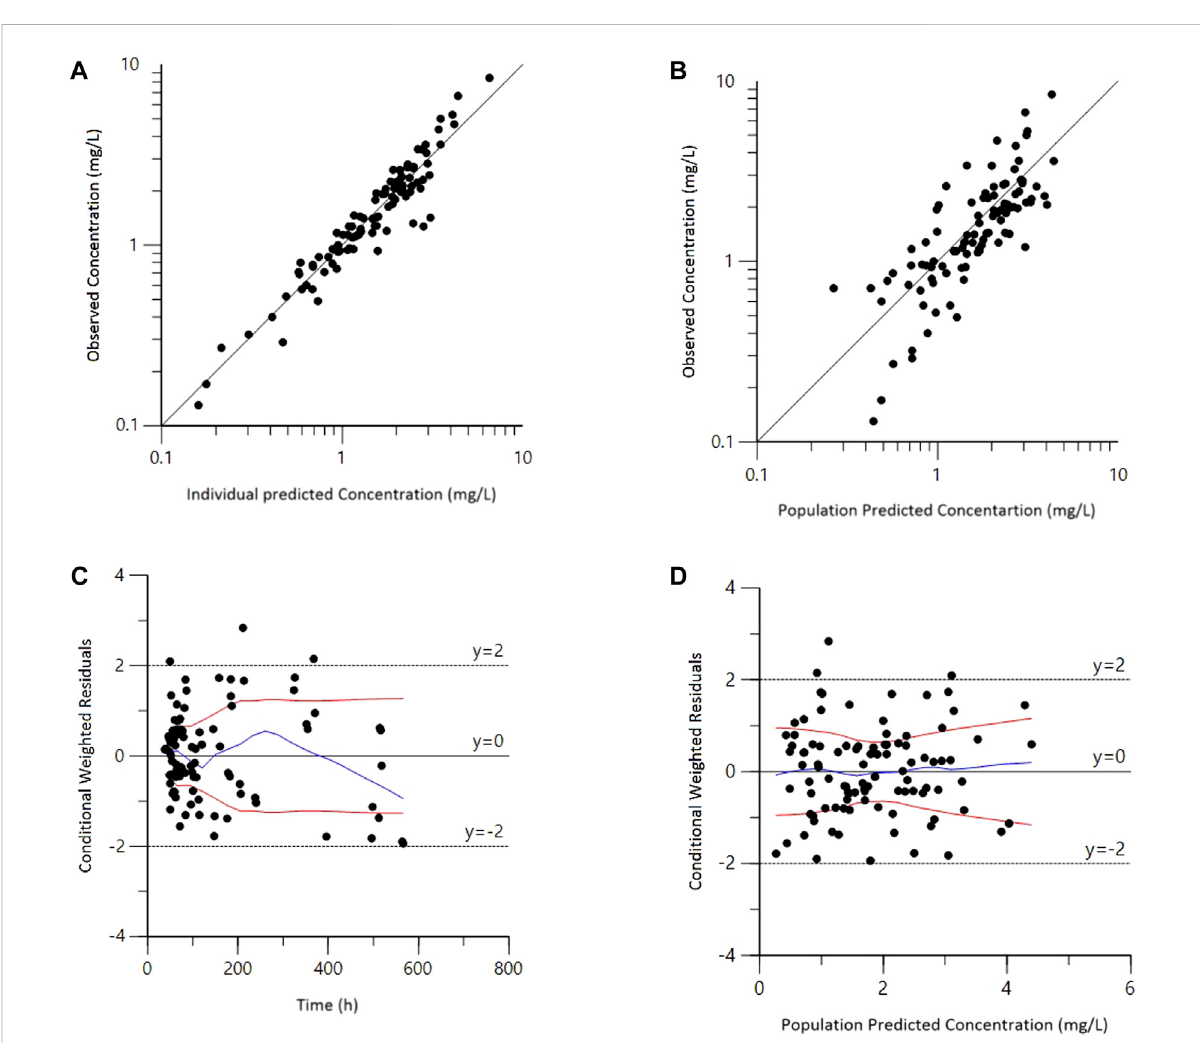
FIGURE 1 Goodness-of- fi tplotsforthe fi nalpopulationpharmacokineticmodel. (A) Observedversuspopulationpredictedconcentrations(DVvs.PRED); (B) Observed versus individual predicted concentrations (DV vs. IPRED); (C) Conditional weighted residuals versus time (CWRES vs. IVAR); (D) Conditional weighted residuals versus population predicted concentrations (CWRES vs.